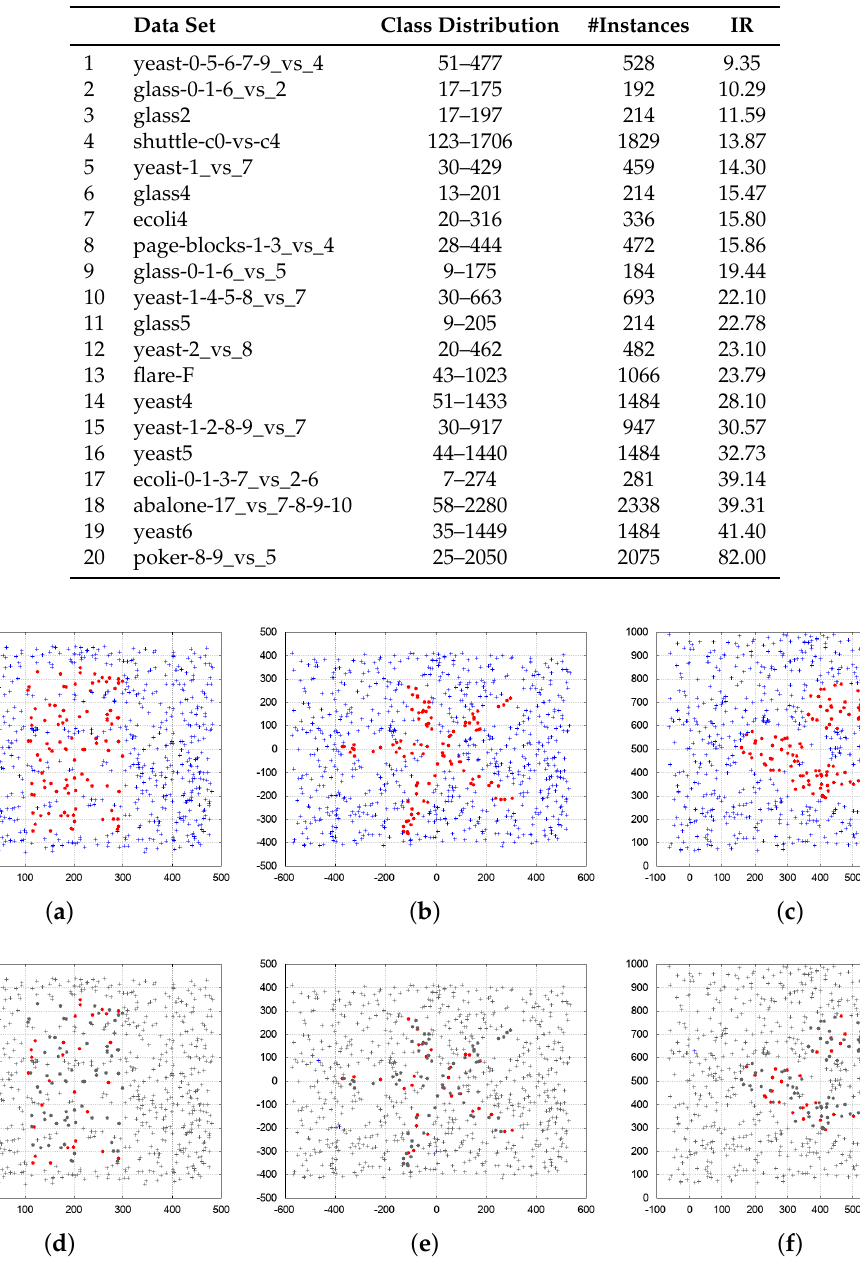
Table 1. Summary of the real-life data sets.